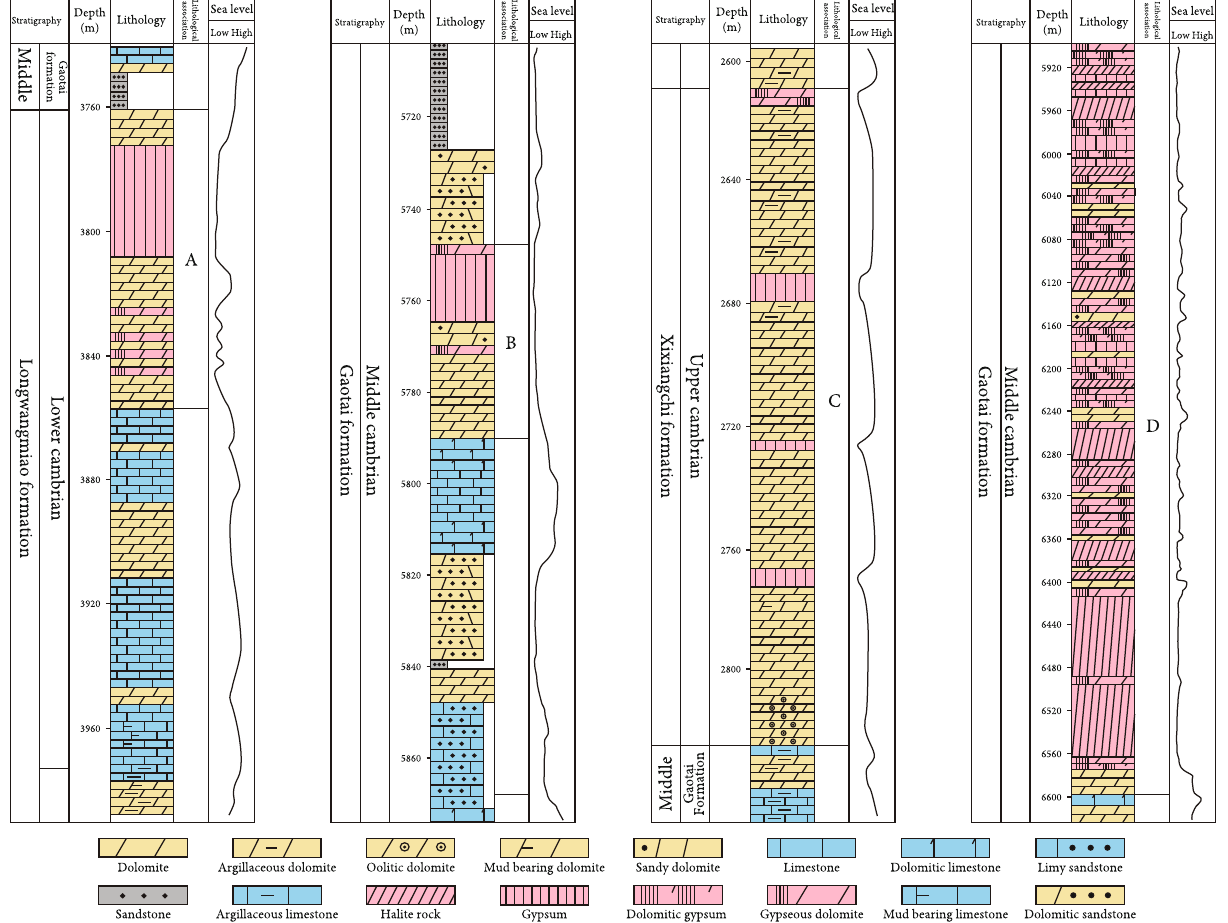
Figure 2: Lithological association of DEPS. (a) Interbedding of dolostone and evaporite (Gongshen 1 Well, Longwangmiao Formation). (b) Evaporite overlying thick dolostone (Zuo 3 well, Gaotai Formation). (c) Thick dolostone mixed with thin evaporite (Dingshan 1 well, Xixiangchi Formation). (d) Thick evaporite mixed with thin dolostone (Loutan 1 Formation) [27, 29, 38,